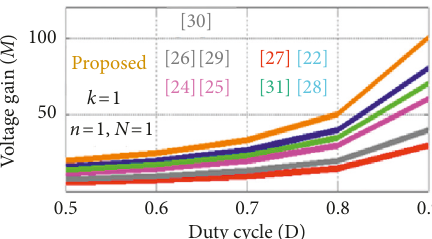
Figure 11: Comparison of the proposed converter in terms of voltage gain with other similar converters in Table